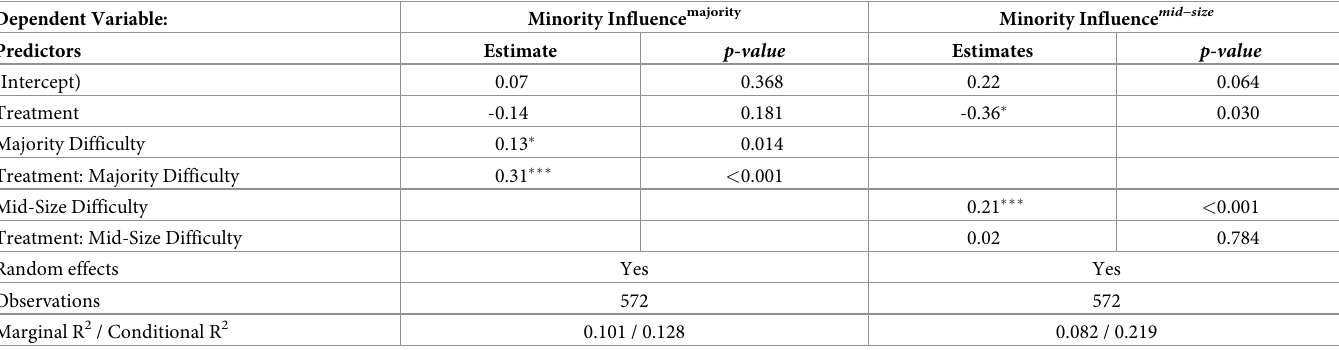
Table 2. Mixed models for minority influence. The VAE bot was successful at increasing minority influence when the majority cluster faced difficult decisions and major- ity players were thus most uncertain about their responses. The VAE bot was also successful at increasing 2-person minority cluster’s influence on the mid-sized 3-person group.